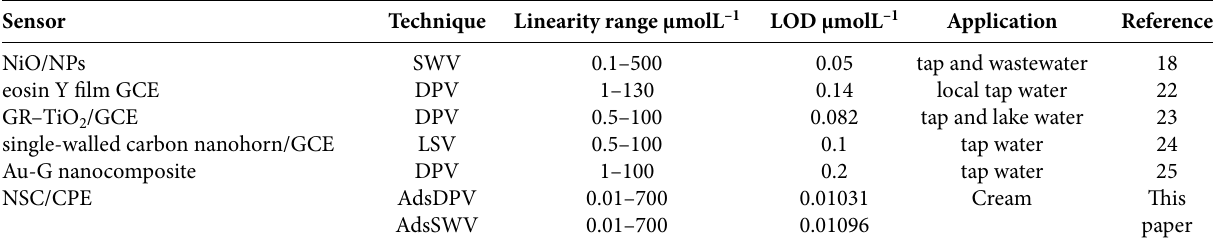
Table 3. The comparison of the performances of various electrochemical sensors for HQ analysis. Sensor